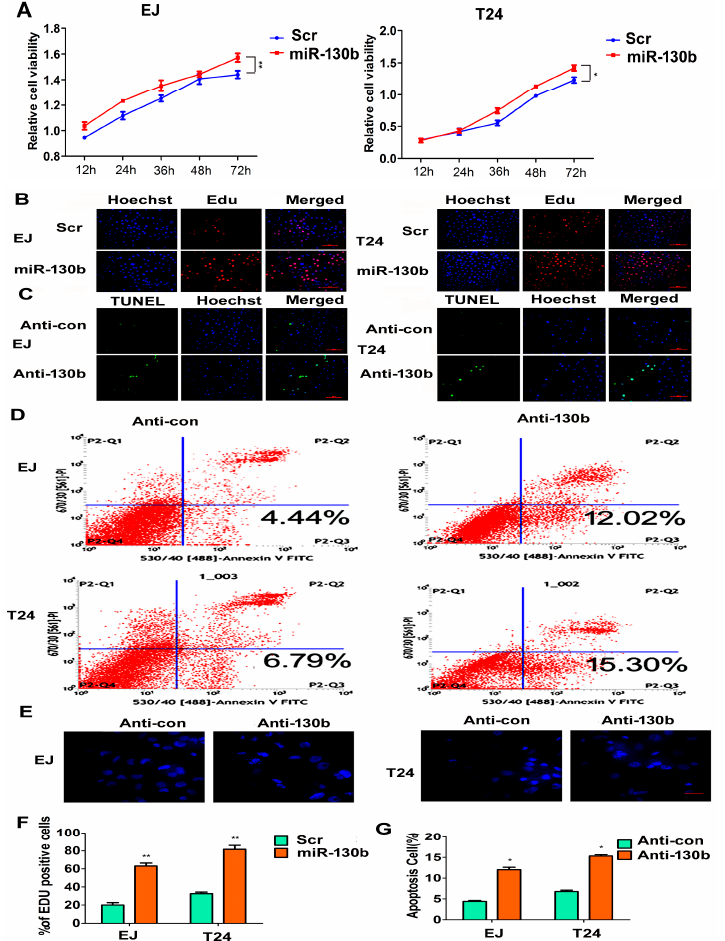
Figure 6. miR-130b-3p affects cell proliferation and apoptosis. ( A ) CCK8 analysis of EJ or T24 cells transfected with miR-130b-3p mimics or the scramble control; * p < 0.05, ** p < 0.01; ( B ) Representative images of the Edu assay of EJ or T24 cells transfected with miR-130b-3p mimics or the scramble control. Hoechst stains the nucleus. Scale bar = 100 µ m; The blue spots are the nuclear, the red spots are the proliferative cells; ( C ) Representative photographs of TUNEL staining of EJ or T24 cells transfected with inh-130b or the scramble control. Hoechst stains the nucleus. Scale bar = 100 µ m; The blue spots are the nuclear, the green spots are the apoptotic cells; ( D ) Flow cytometry analysis with Annexin V-PI staining. The percentage of apoptotic cells in EJ or T24 groups transfected with anti-130b or anti-con, respectively; ( E ) Representative nuclei images of Hoechst staining. Scale bar = 50 µ m; ( F ) Quantitative Edu assay data in five fields. Mean ± SD. ** p < 0.01; and ( G ) Quantitative Tunel assay data in five fields. Mean ± SD. * p <